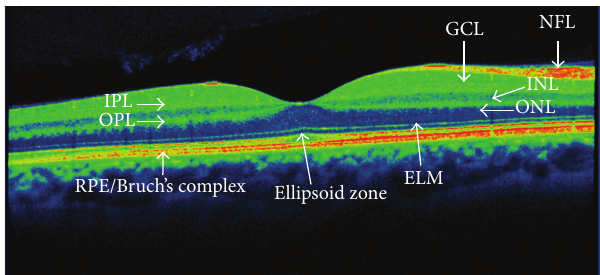
Figure 1: Optical coherence tomography of the macular area, descriptionofdifferentlayers:RPE/Bruch’scomplex:retinalpigment epithelium and Bruch’s layer; ELM: external limiting membrane; ellipsoid zone: inner segments/outer segments of photoreceptors (ellipsoid layer); ONL: outer nuclear layer (photoreceptors); OPL: outer plexiform layer; INL: inner nuclear layer (bipolar cell); IPL: inner plexiform layer; GCL: ganglion cell layer; NFL: nerve fiber